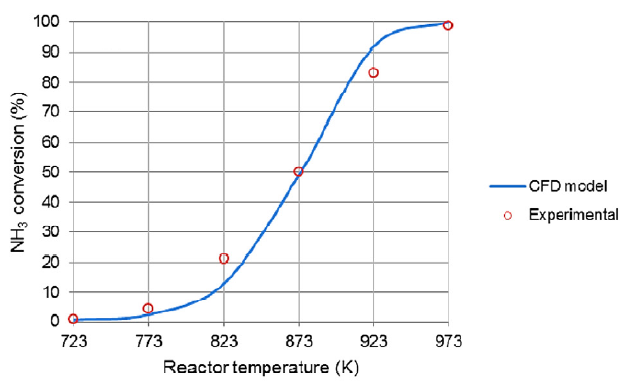
Figure 5. NH 3 conversion versus reactor temperature [28].